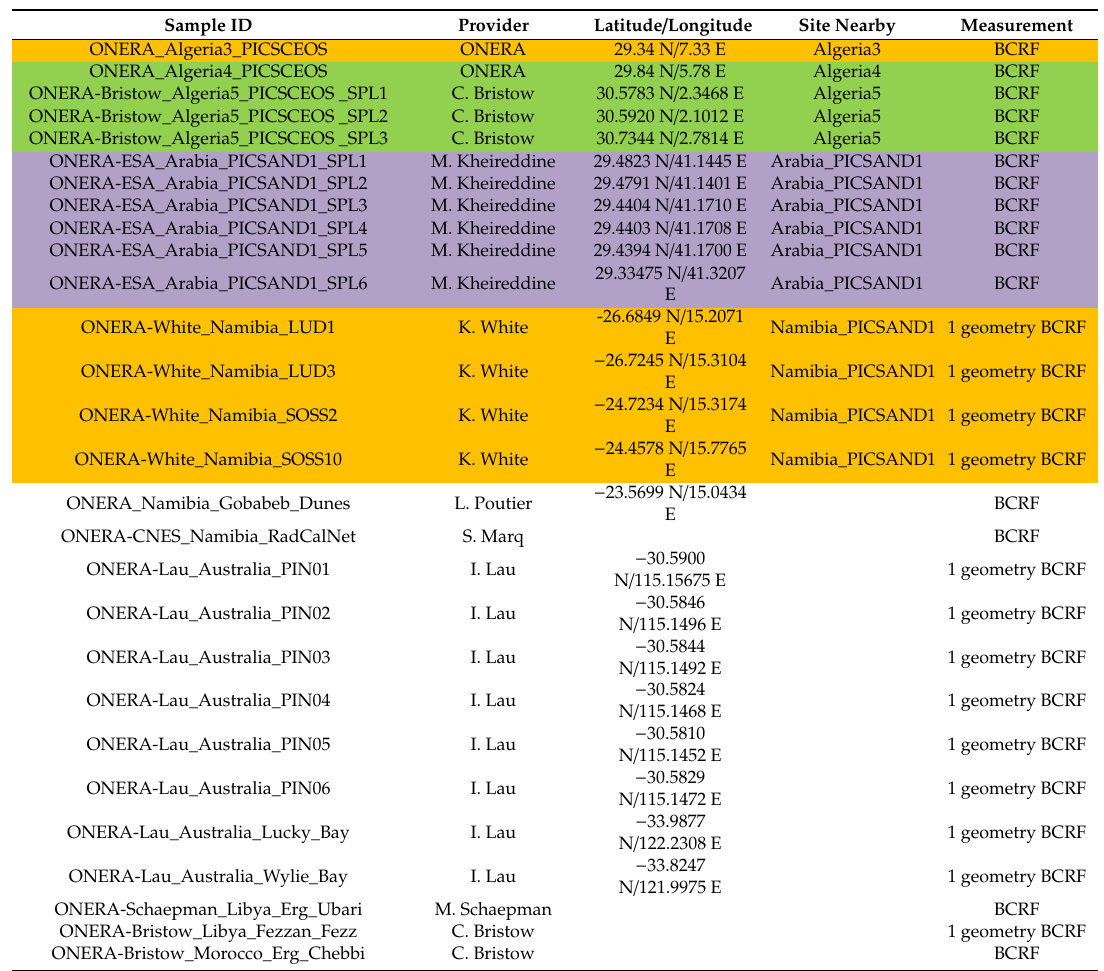
Table 2. Overview of the sand samples. Samples coming from a PICS of the CEOS list appear in the green cells. Samples coming from a site identified as a potential PICS by [3] appear in the purple cells and are referred to as PICSAND (the name of the database). Samples close to a PICS or a PICSAND site appear in the orange